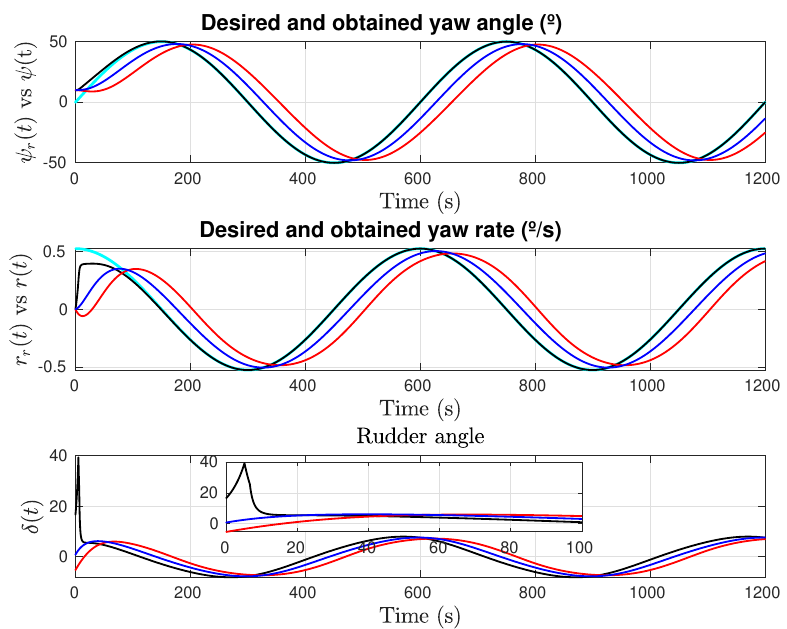
Figure 9. Sinusoidal yaw reference test with d ( t ) = 0. States and control. Cyan line: Reference; Red line: Concise backstepping (Zhang et al.); Blue line: Synergetic (Muhammad et al.); Black line: Adaptive sliding mode (González-Prieto et al.).